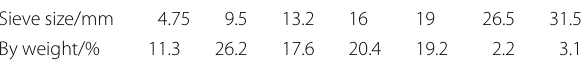
Table 2 Gradation of coral aggregate.